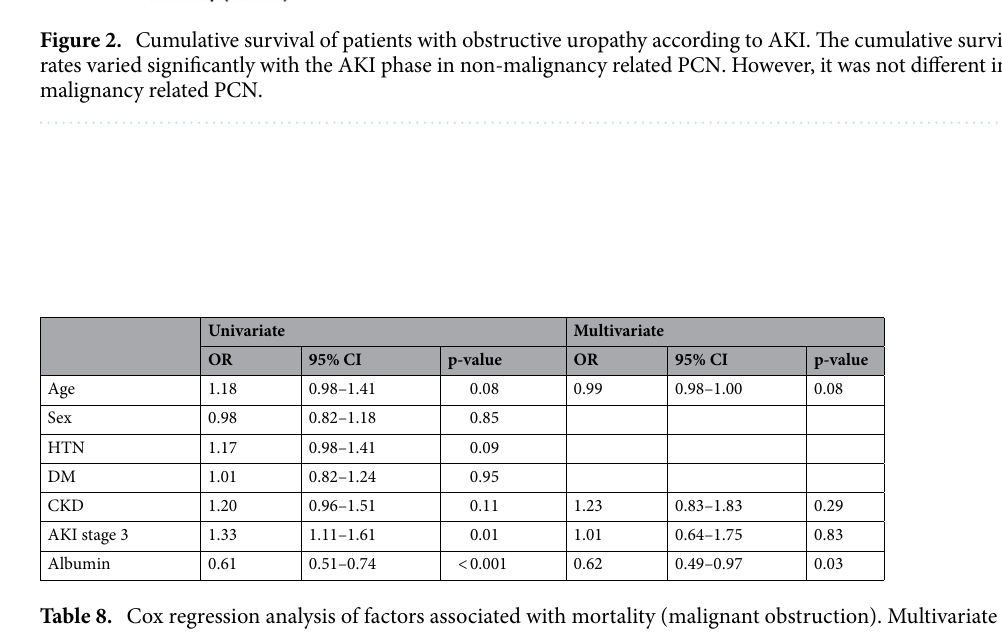
Table 8. Cox regression analysis of factors associated with mortality (malignant obstruction). Multivariate Cox regression analysis was conducted after adjustment for sex, age over 65 years, hypertension, diabetes mellitus, ischemic heart disease, underlying liver disease, chronic kidney disease (eGFR ≤ 60 ml/min/1.73 m 2 ), KDIGO stage 3 AKI, Hb < 11 g/dL, CRP, and albumin. AKI acute kidney disease, HTN hypertension, DM diabetes mellitus, CKD chronic kidney